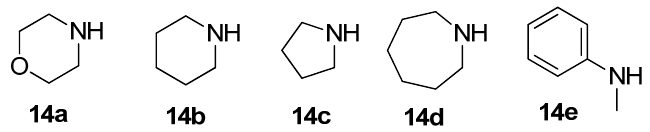
Figure 6. Diversity reagents 14 for tertiary 1,2,3-triazoloamides 2 .